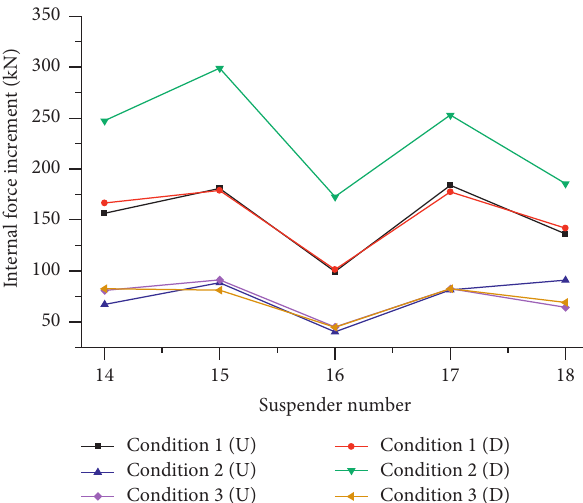
Figure 11: Internal force increments of